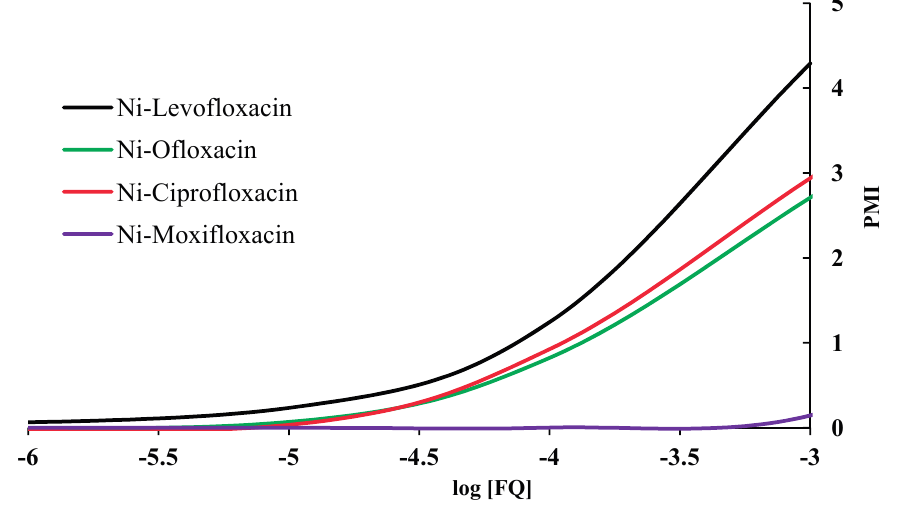
Figure 14. The effect of fluoroquinolone ligands on plasma mobilization of nickel.